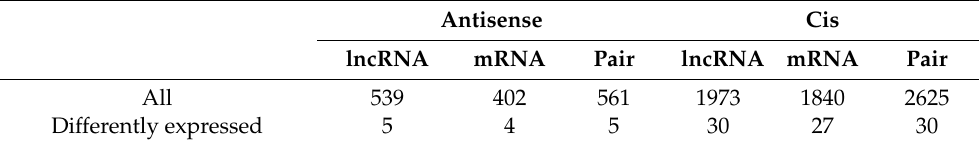
Table 2. LncRNA-mRNA interaction analysis. Antisense Cis lncRNA mRNA Pair